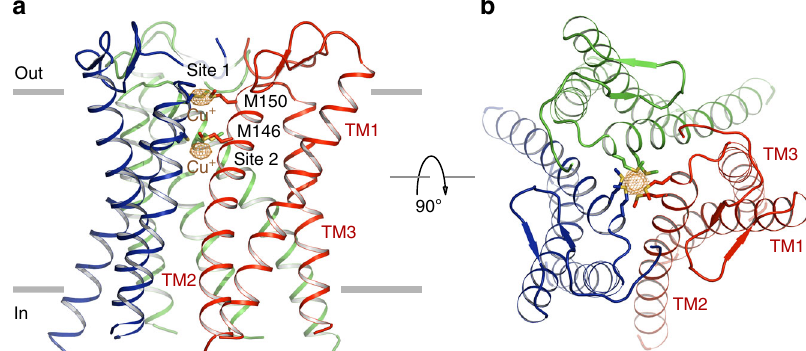
Fig. 4 Cu + selectivity fi lter. a Two bound Cu + ions at the selectivity fi lter. The anomalous difference electron density, calculated from diffraction data in the 20 – 3.6 Å resolution and contoured at 8.0 σ , is shown as orange mesh, indicating bound Cu + ions. Also shown are the side chains of the methionine residues (M146 and M150) in the fi lter. b Orthogonal view as in ( a )